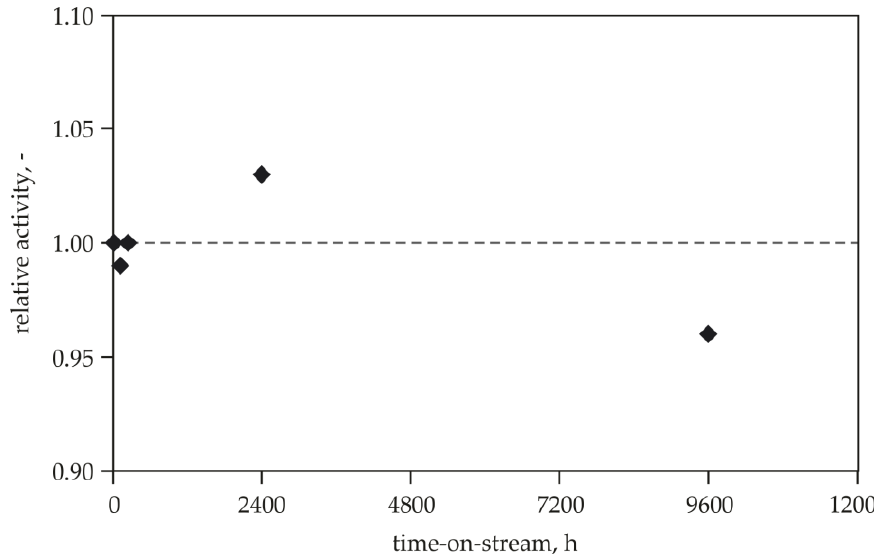
Figure 2. Long-term stability test of the PKR catalyst. Test parameters: T NG = 890 °C, p = 5 bar, V NG = 58Nm 3 /h.